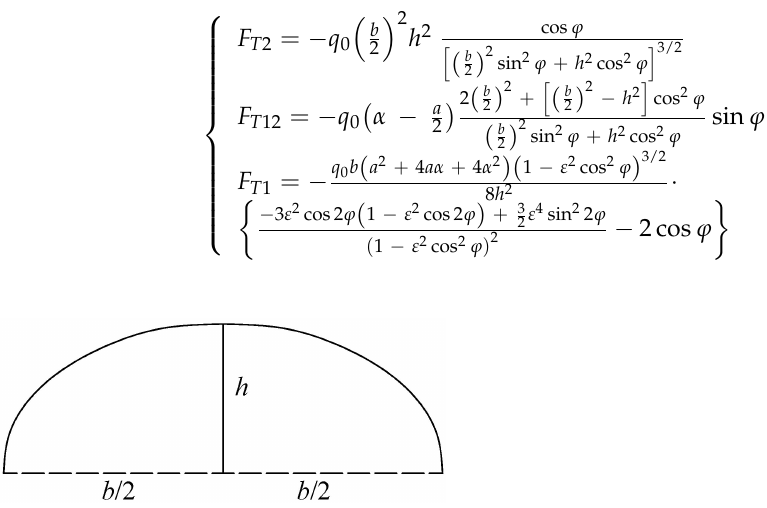
Figure 6. Schematic diagram of a semielliptical top cover cylindrical